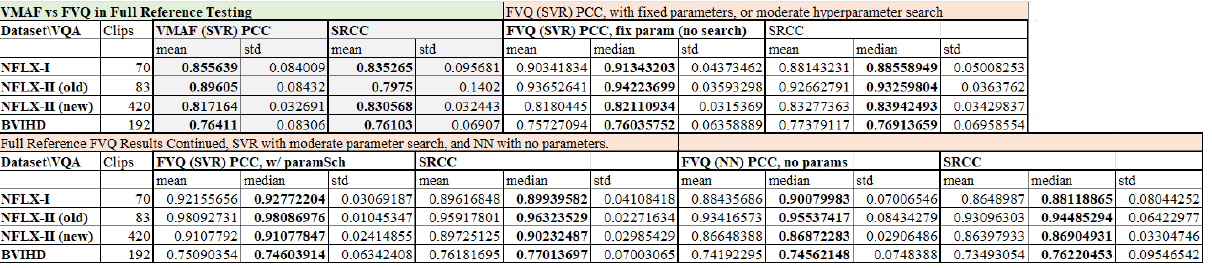
Figure 2. Simulation results for FVQ for full-reference (FR) testing, compared to the well-known VMAF algorithm. In our tests, for a fair comparison, we trained/tested on each dataset, splitting the data randomly 80/20 for SVR, 85/15 for NN, and repeating the test 50 times. Our results show that we outperformed VMAF on these test datasets with both SVR and NN. We believe the gains derive from both a better motion feature than VMAF, as well as better regression. While VMAF also regresses using an SVR, we obtained gains by using improved hyperparameters (no search), as well as with moderate search. Using a modern GPU, our computationally fastest regressor engine was an NN (e.g., a simple 6-80-64-1 fully connected feedforward network, with Relu activation, and RMSProp optimization), which achieves excellent results.